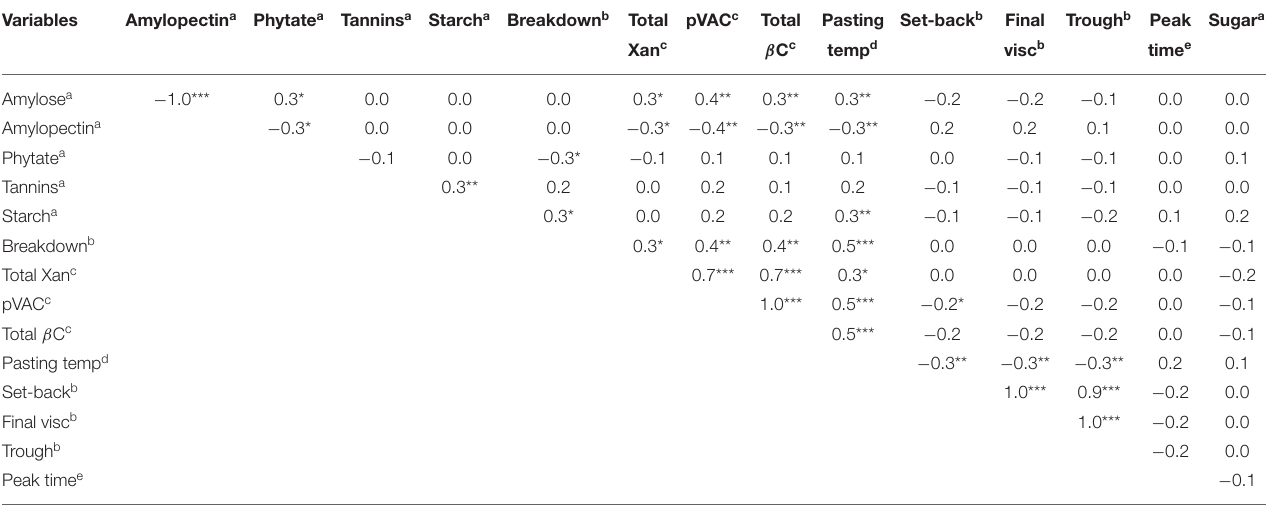
TABLE 5 | Correlation between bioactive components, carbohydrate profile and pasting properties of Striga -resistant yellow-orange maize hybrids grown at Zaria and Saminaka.